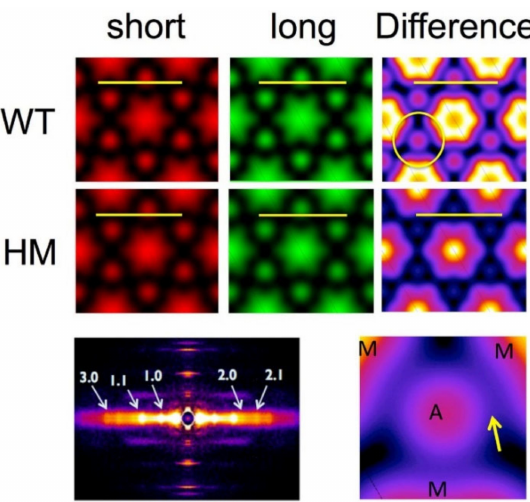
Figure 3. Electron density maps. Axially projected electron density maps calculated from the first five equatorial reflections. A: thin filament; M: thick filament. Calibration bar = 50 nm. Reprinted from Ref. [75]. In the difference maps, colored regions are those that have increased density at longer sarcomere length with brighter colors indicating greater increased